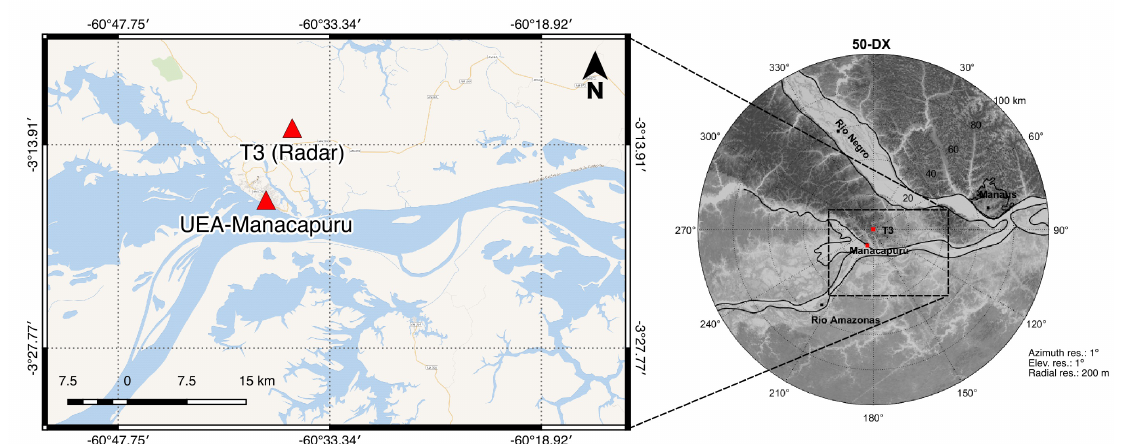
Figure 2. Position of the X-band radar and of the rain gauges indicated with a thumbtack in each site, during Manaus